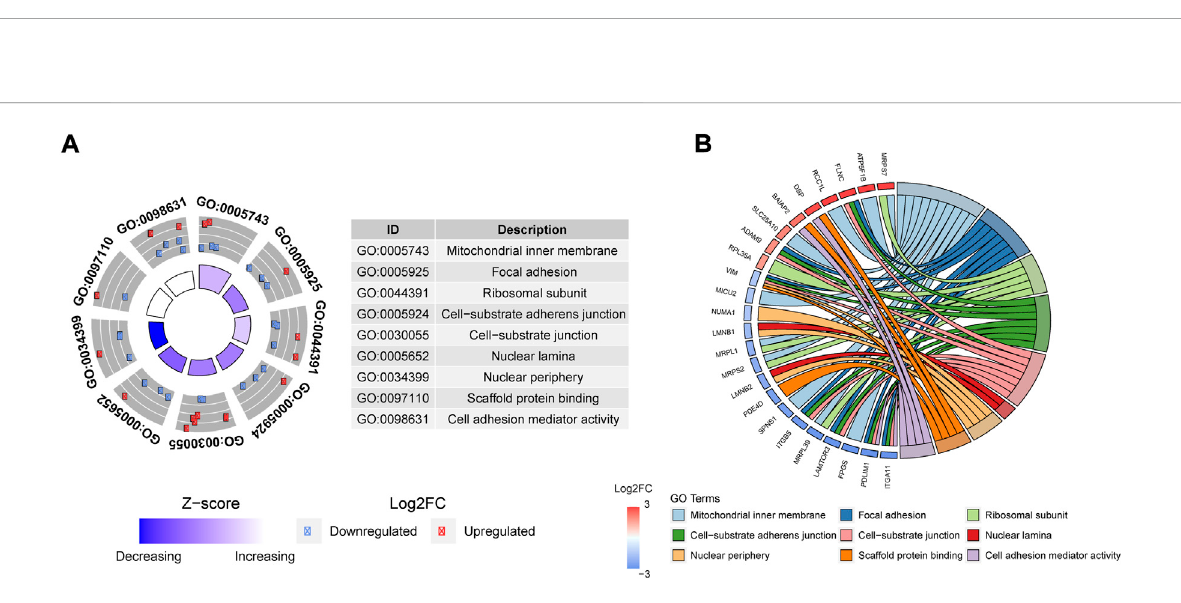
FIGURE 4 Enrichment analysis based on Gotermsfor proteomic data. (A) GoCircle-plot that includes signi fi cant over-represented GoTermsin atable (ID and Name) and scatter plot with FC of any gene related with each GoTerm. Moreover, this plot includes Z-score which is an estimation of up- regulation or down-regulation in the Goterm. (B) Circus-Plot applied to Goterms to relate any Gene name with the corresponding GoTerm name. The plot also shows the FC of each gene, and the list is sorted by FC from the most over-expressed (3) up to the most under-expressed ( −